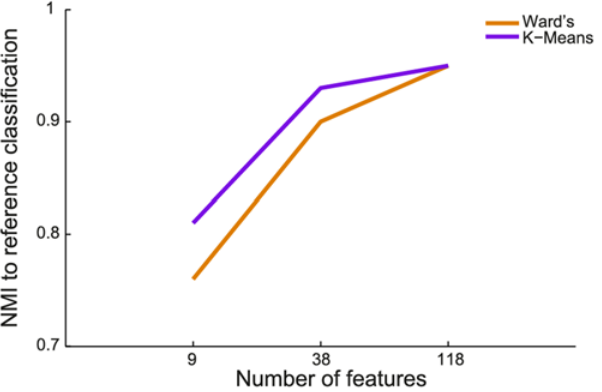
Fig 4. Sensitivity of the algorithm performance (normalized mutual information) between the human- made reference classification and K-means (purple), and Ward ’ s (orange) clustering for the three feature sets. NMI values have been calculated for k = 5 clusters.